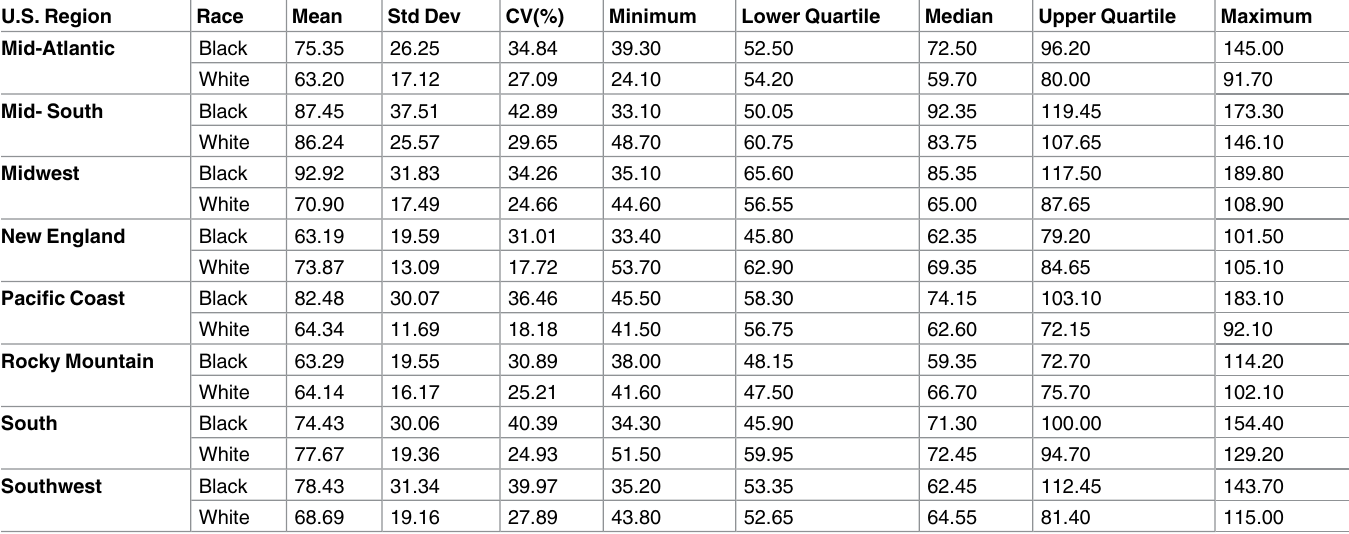
Table 5. Summary statistics of lung cancer incidence rates for Blacks and Whites in 8 U.S. Geographic Regions, 1999–2012(cases per 100,000). U.S. Region